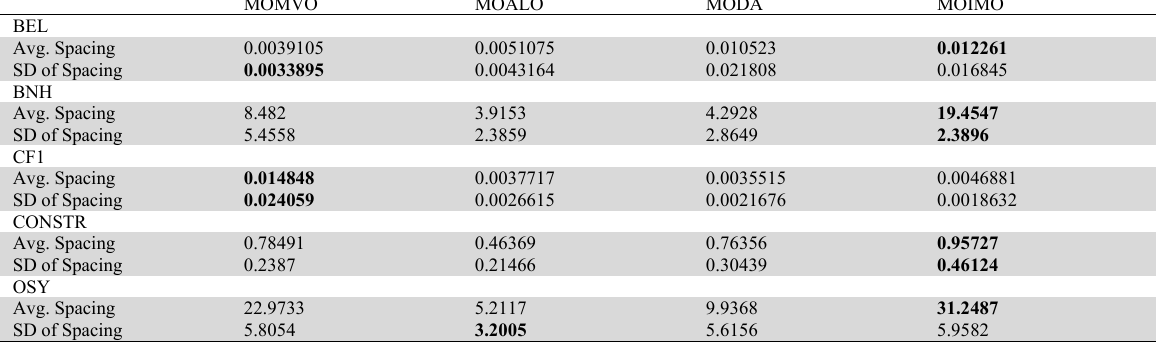
Results of the multiobjective algorithm (using spacing) on the constrained test functions MOMVO Avg.